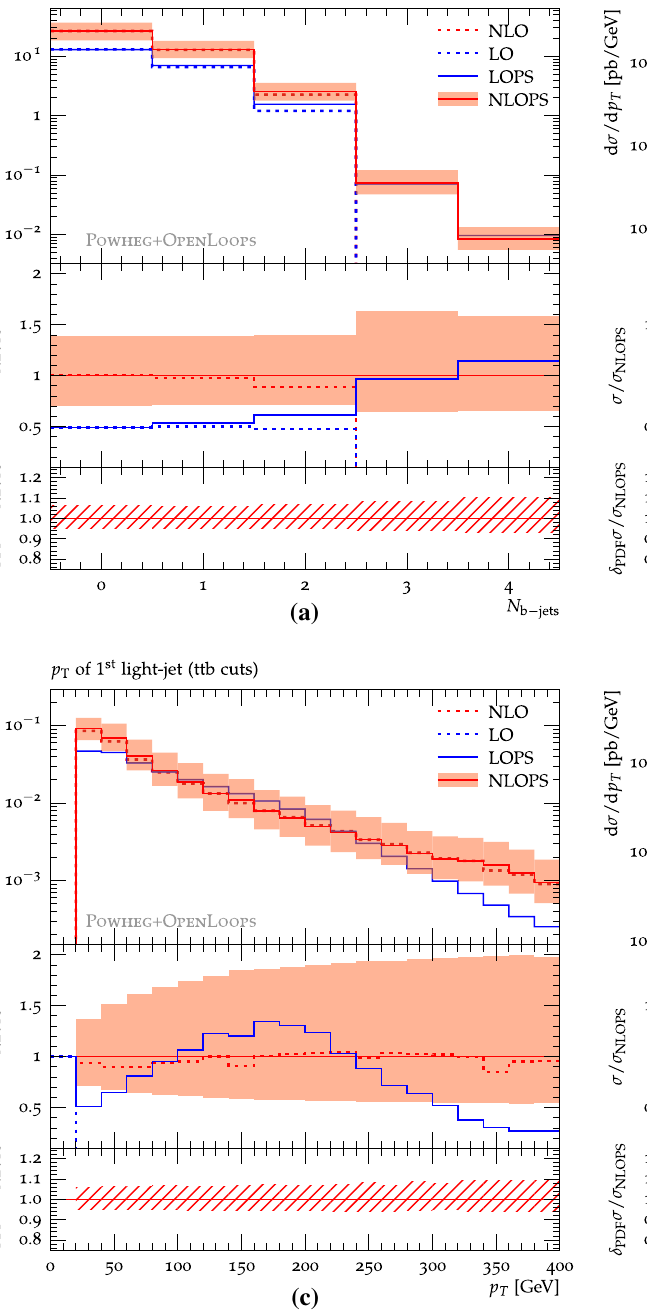
√ s =13TeV: distributions in the Fig. 7 Predictions for pp → t ¯ tb ¯ b at envelope of 7-point μ R ,μ F variations. Absolute predictions are shown inclusive number of additional b -jets ( a ), the p T of the first b -jet ( b ) and inthe mainframe. The first ratioplot shows LO, LOPS and NLOPS pre- dictions normalised to fixed-order NLO. The second ratio plot displays the first light jet ( c ) with ttb cuts, and in the p T of the second b -jet with the relative effect of PDF uncertainties applied to NLOPS predictions ttbb cuts ( d ). Results at LO and NLO are in blue and red, respectively, Top quarks are kept stable and dashed lines correspond to fixed-order (N)LO predictions, while solid curves represent (N)LOPS predictions. The bands illustrate the